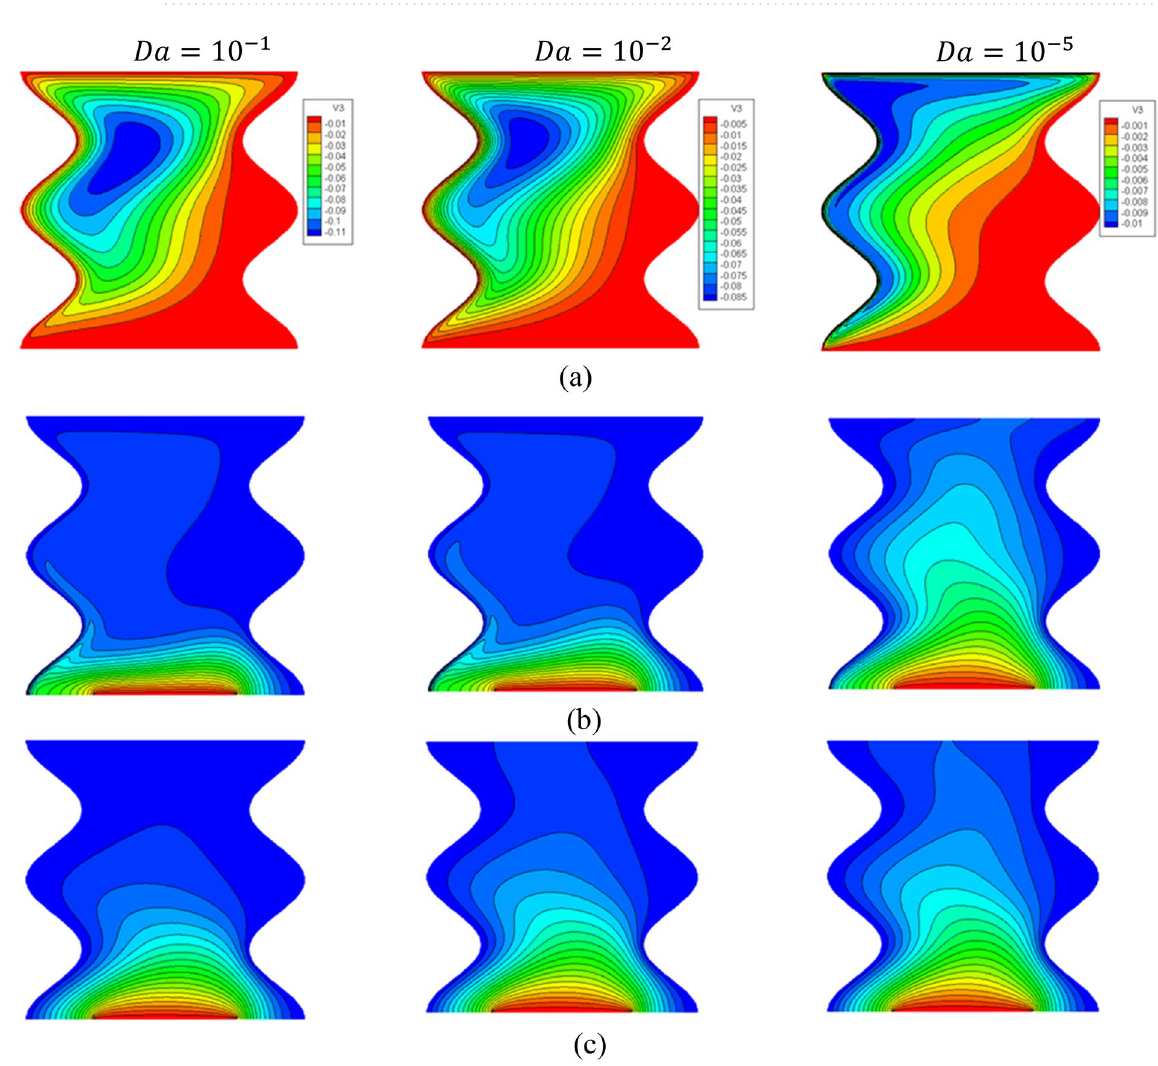
Figure 19. Contours of ( a ) streamlines, ( b ) isotherms of a fluid phase, and ( c ) isotherms of a solid phase below the changes on Darcy parameter for a hybrid nanofluid at φ Cu R d = 0.5, k r = 1, ε = 0.5, k fs = 1, D = 0.5, H ∗ = 10, Ha =